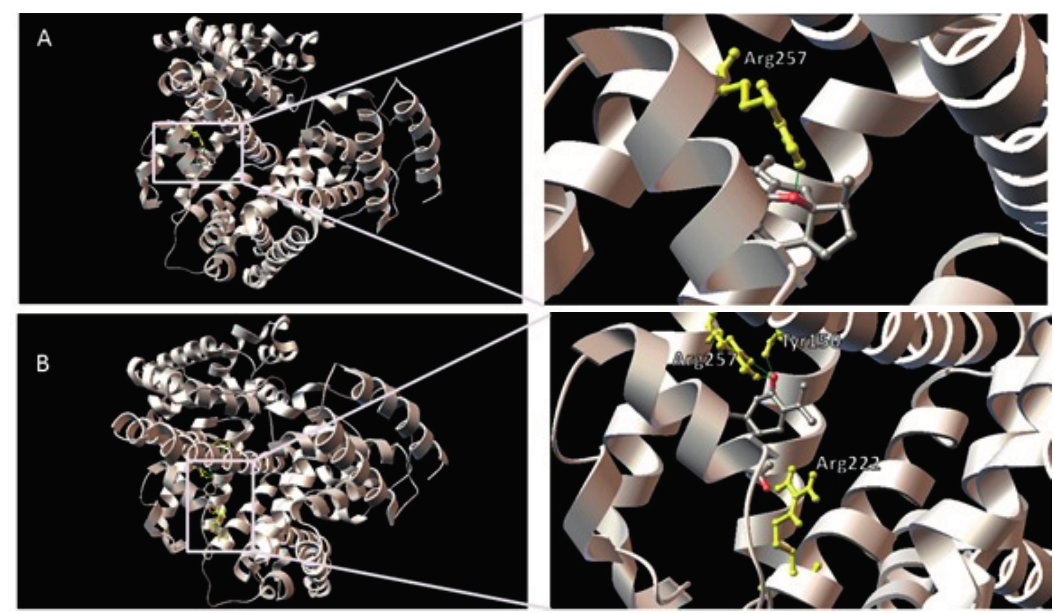
Figure 7. Predicted orientations of the lowest docking energy conformations of 1BM0-ligand complexes. The binding sites were enlarged to show hydrogen bonding (green lines) between amino acid residues and the ligands. Amino acid residues that form hydrogen bonds with the ligands are rendered in ball and stick and colored yellow. ( A ) Curcumenol in the binding site I of HSA (1BM0); ( B ) Curcumenone in the binding site I of HSA (1BM0).